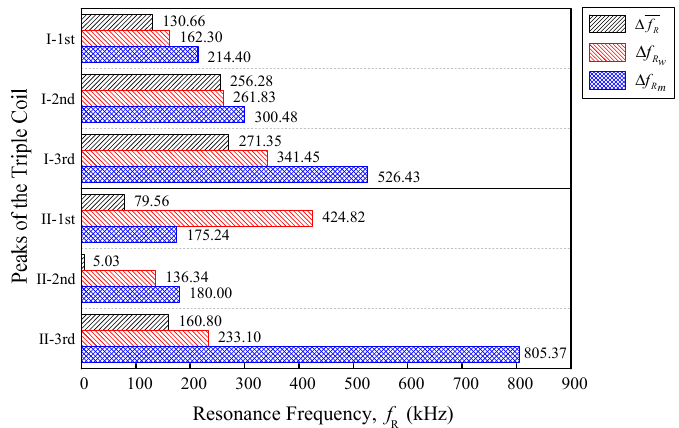
Figure 12. Triple I and II resonance frequency evaluation comparison for ∆(cid:1858) (cid:3019) (cid:3365) , Δ(cid:1858) (cid:3019)